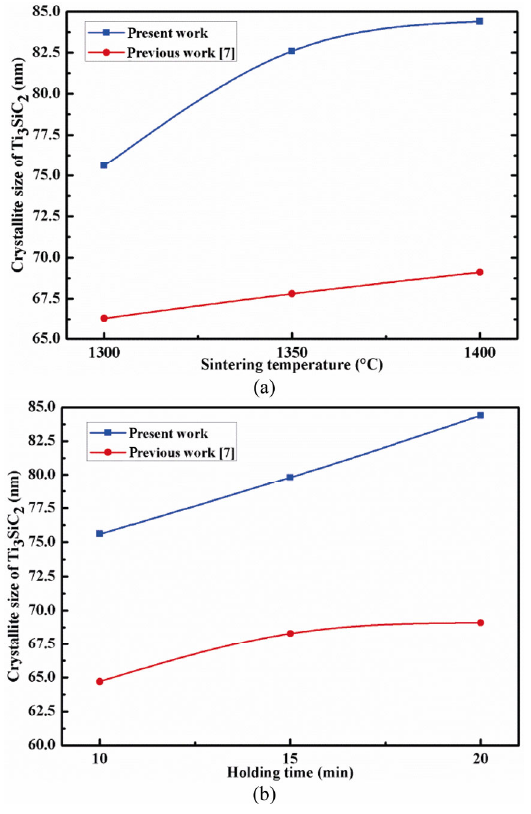
Fig. 8 Evolution of the Ti 3 SiC 2 crystallite size, for present work and previous work [7], as function of (a) sintering temperature and (b) holding time.